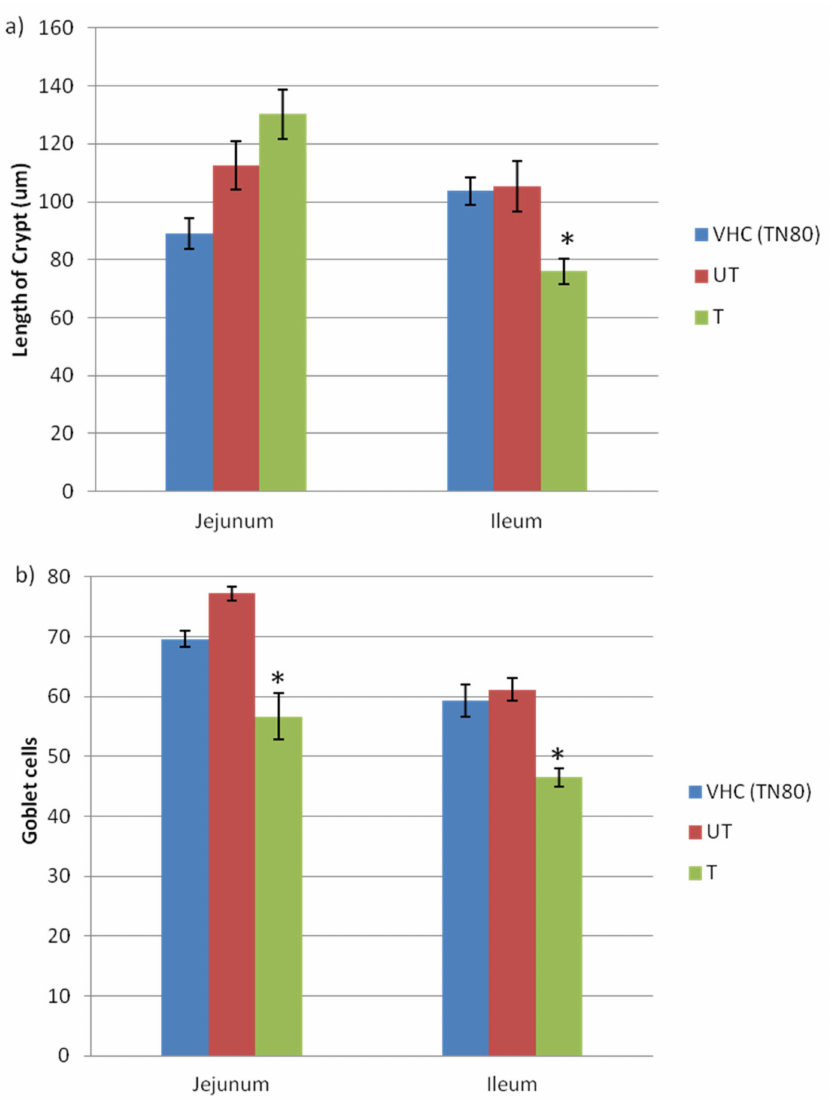
Figure 5. Effects of BPA on ( a ) crypt and ( b ) goblet cells of villi in the jejunum and ileum of pregnant rats ( n = 3–5 rats per group). * Significant as compared to VHC group at p <